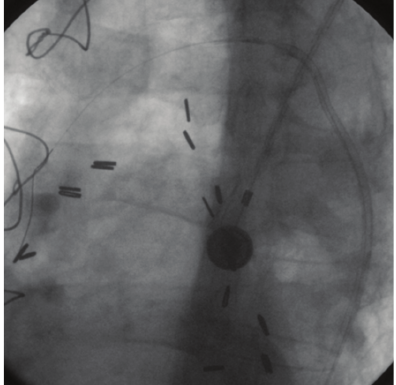
Figure 4: Small balloon, stent, and catheter